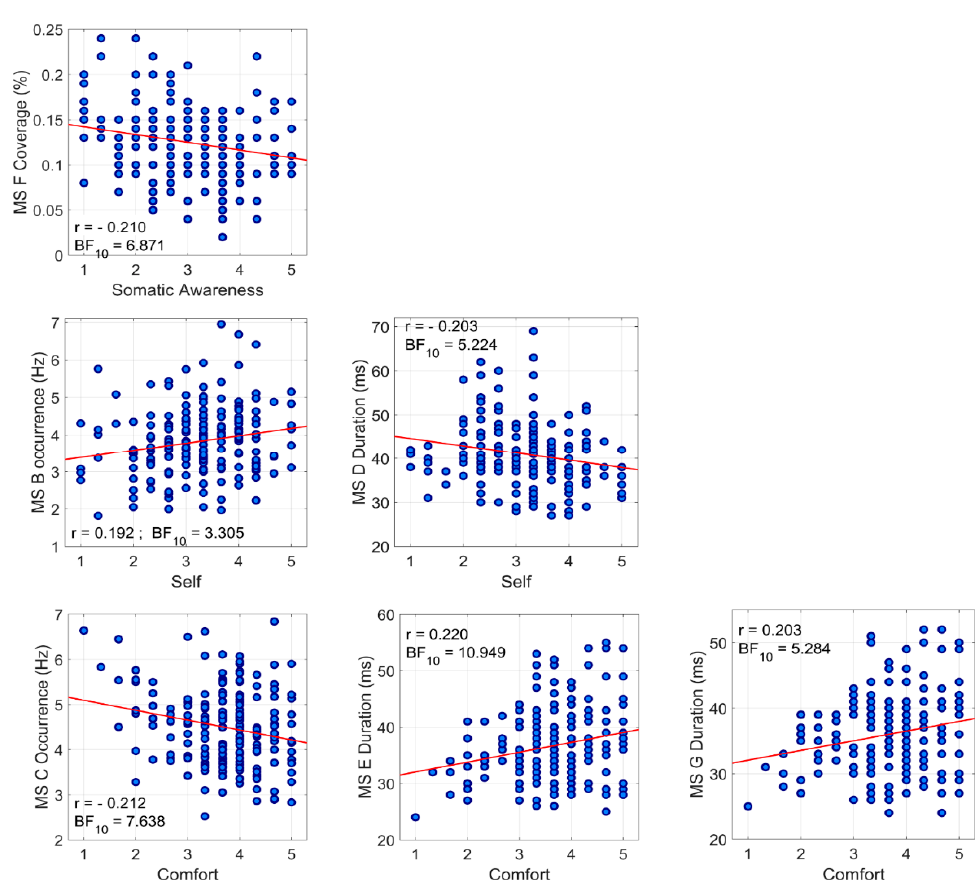
Figure 2. Scatter plots displaying relationship between microstate parameters and Amsterdam Resting-State Questionnaire (ARSQ) dimensions . Table 2. Bayesian Pearson correlation coefficients between microstate characteristics and ARSQ scores.